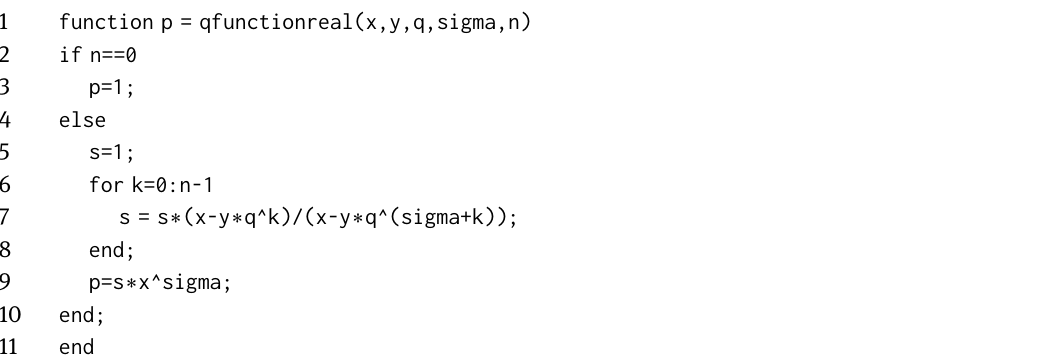
Algorithm 2. MATLAB lines for calculation of q - factorial function (